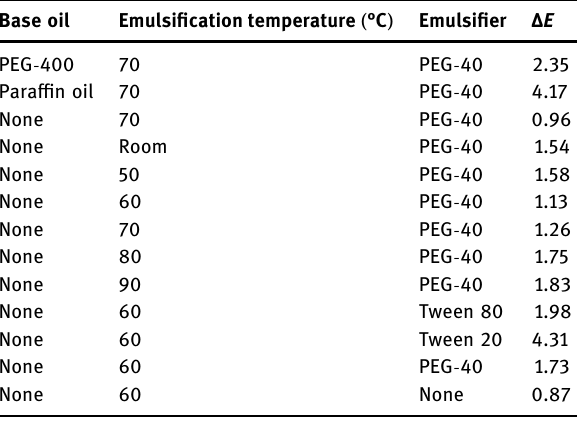
Table 3: Color change of the washing product base after 7 days of storage at 45°C formulated at di ff erent base oils and emulsi fi cation